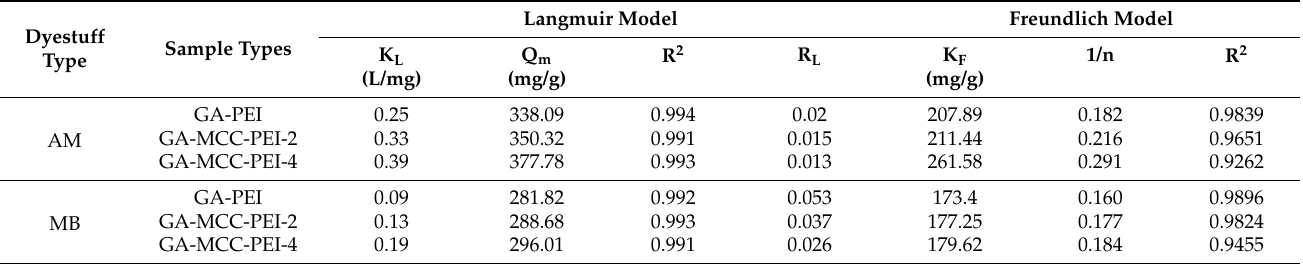
Table 6. Isotherm parameters for the adsorption of amaranth and methylene blue by GA-PEI, GA- MCC-PEI-2, and